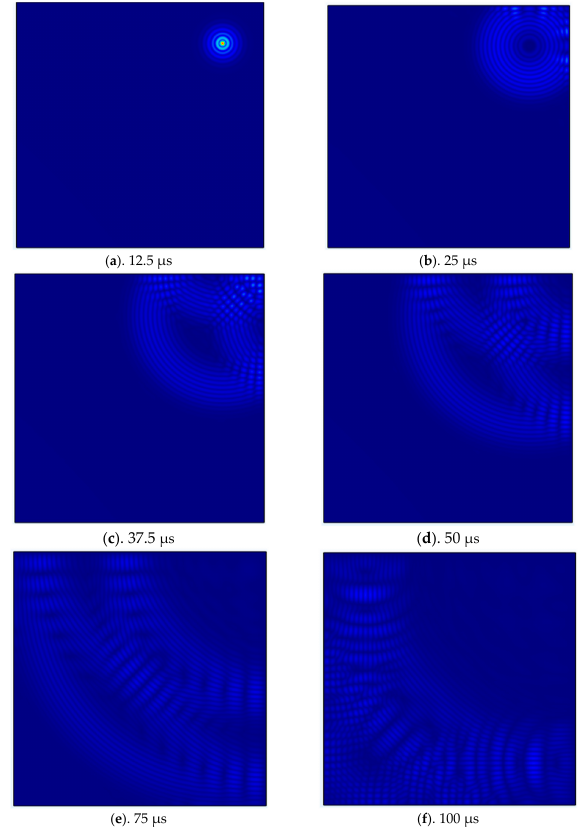
Figure 8. Wavefield diagrams at different times.